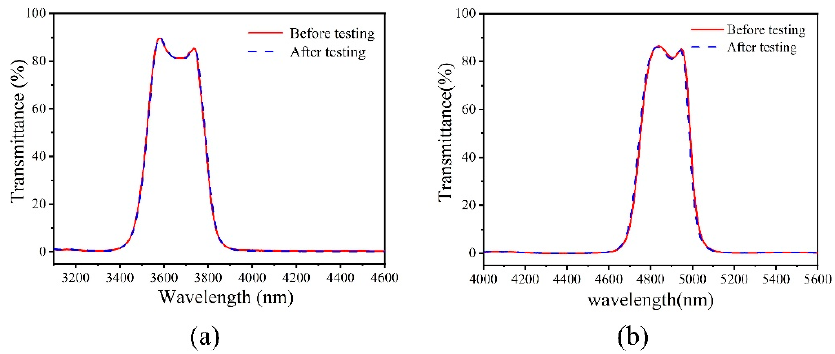
Figure 17. Measured transmittance of ( a ) bandpass filter for the region 3.55–3.75 µm and ( b ) bandpass filter for the region 4.85–4.95 µm before and after UV irradiation. Zinc sulfide (ZnS) and germanium (Ge) were the thin-film materials used.